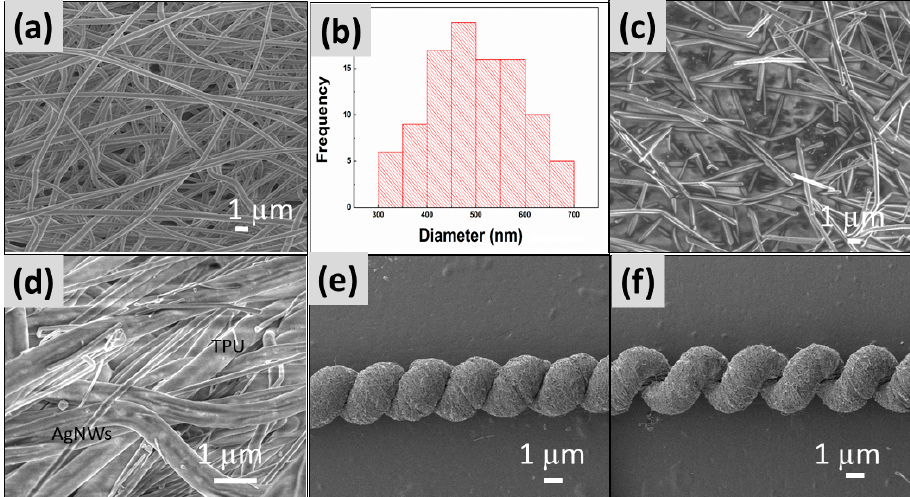
Figure 3. ( a ) SEM image of the electrospun TPU nanofibrous membrane. ( b ) Diameter distribution of an electrospun TPU membrane. ( c ) SEM image of AgNWs. ( d ) SEM image of TPU / AgNWs membrane. ( e ) SEM image of the strain sensor with spring-like configuration under a 0% strain. ( f ) SEM image of the strain sensor with a spring-like configuration under 50% strain.